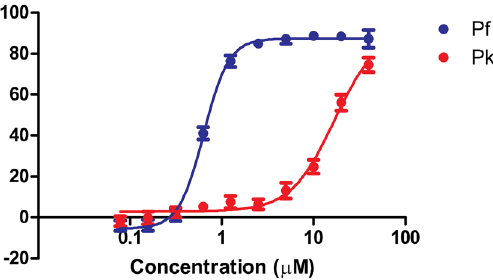
Figure 6. A comparison of the in vitro asexual efficacy of DDD01034957 against P. falciparum (Pf) and P. knowlesi (Pk) over one asexual cycle. Dose response data shows the mean of eight independent replicates with error bars denoting the